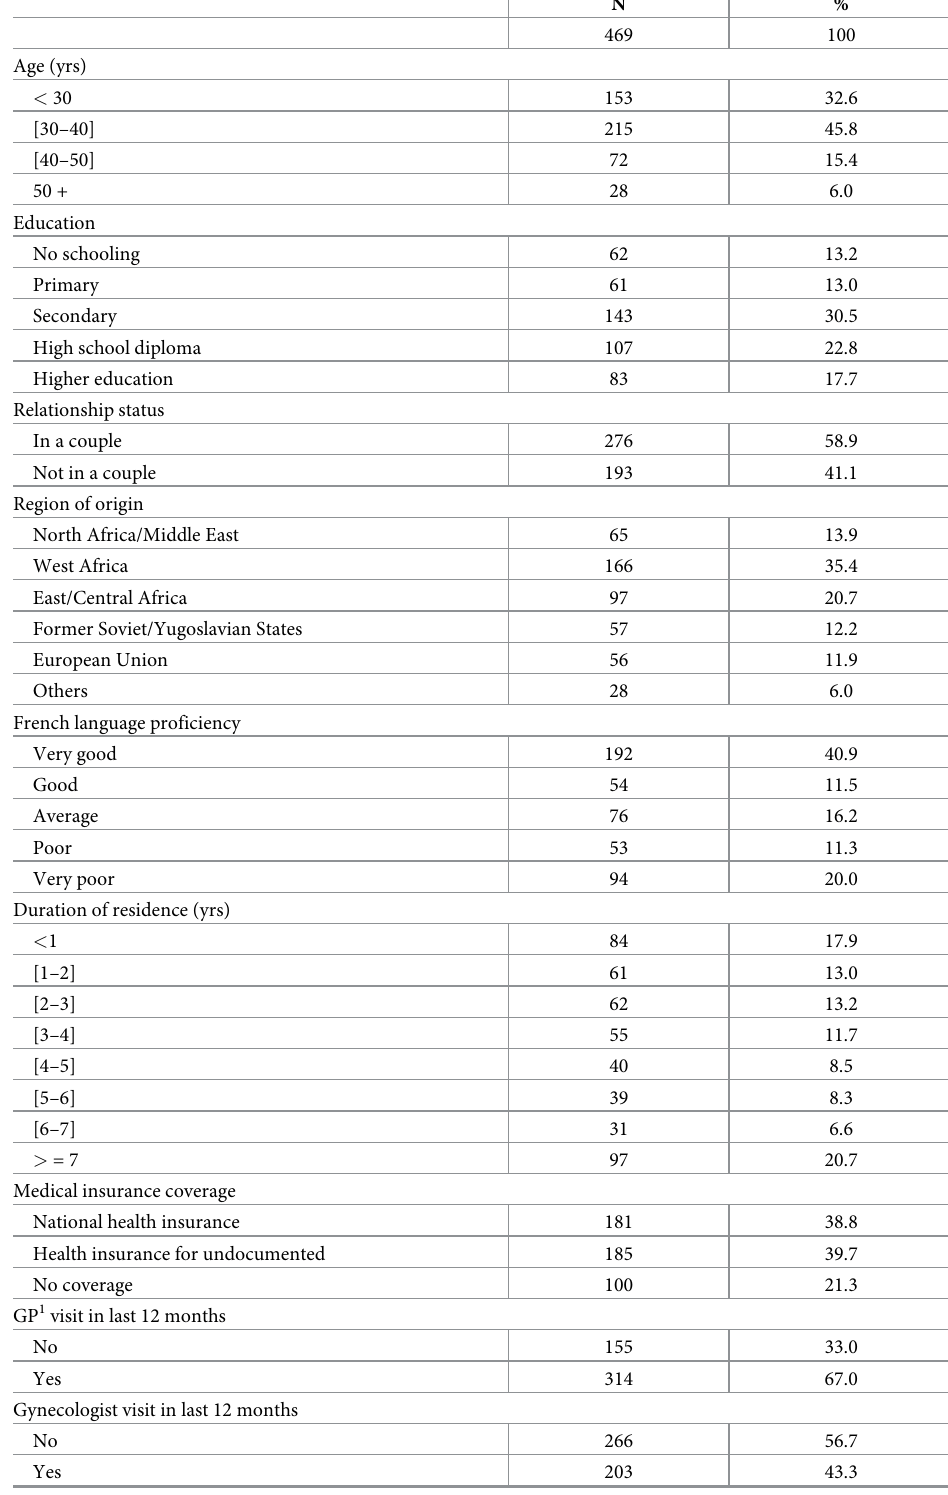
Table 1. Respondents’ characteristics, DSAFHIR